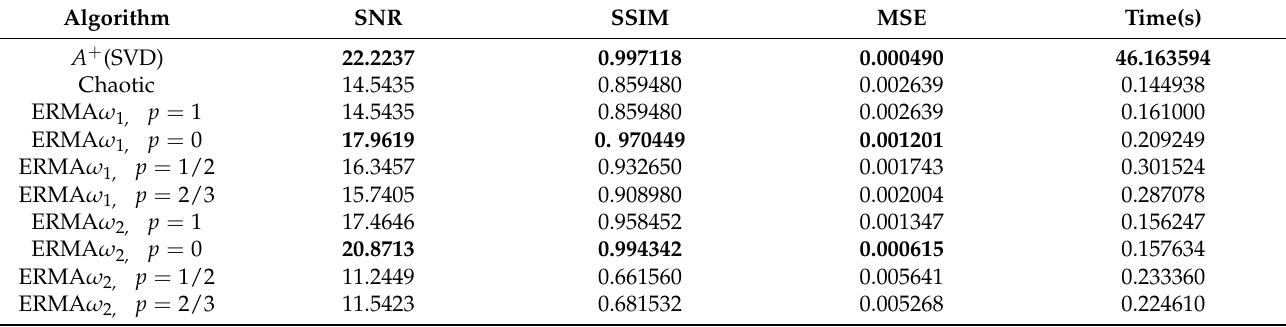
Table 4. The comparison of Figure 4 deblurring results.